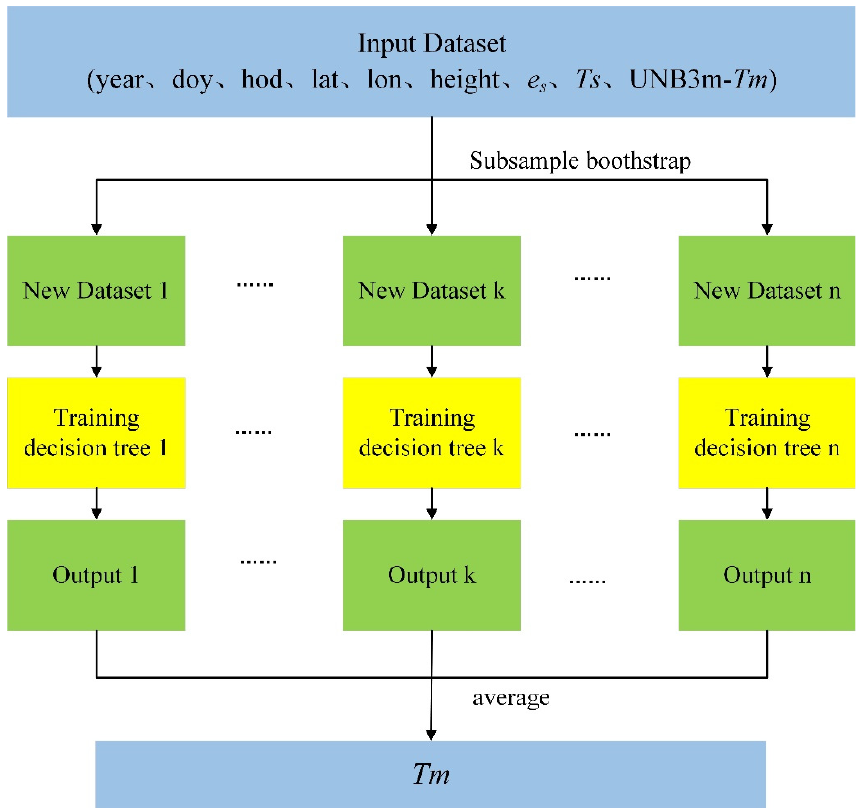
Figure 3. Structural diagram of random